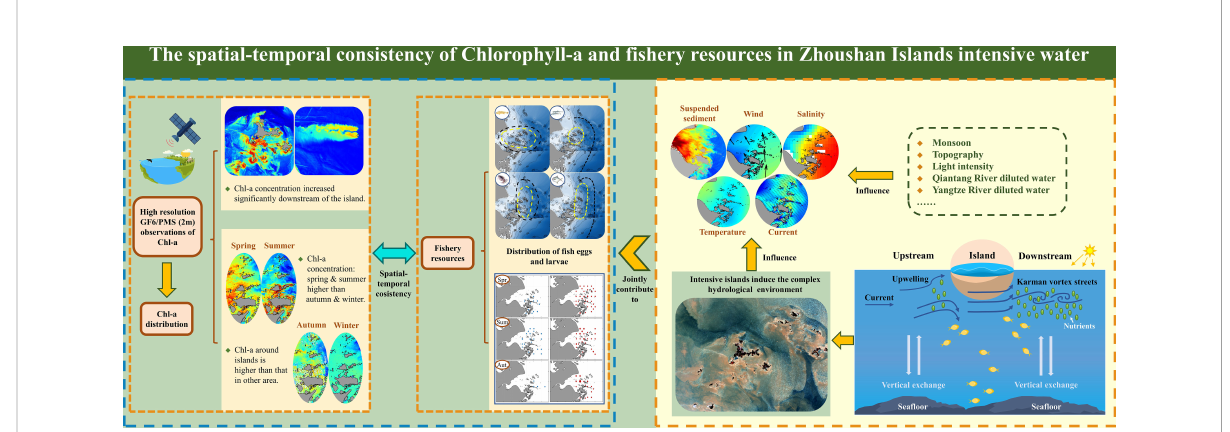
FIGURE 13 The spatial- temporal consistency of Chlorophyll-a and fi shery resources in Zhoushan Islands intensive